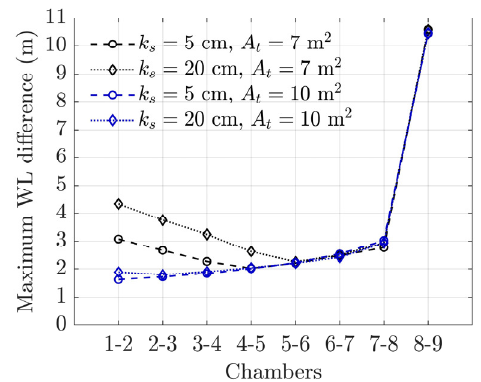
Figure 9. Maximum differences of the water level (WL) in successive chambers of the underground